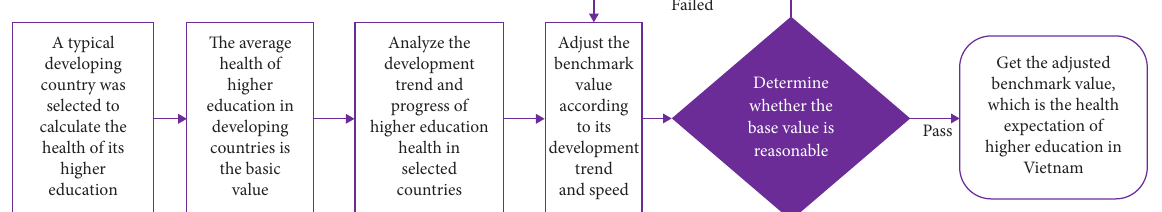
Figure 4: The flowchart of solving the expected value of the health of higher education in Vietnam.